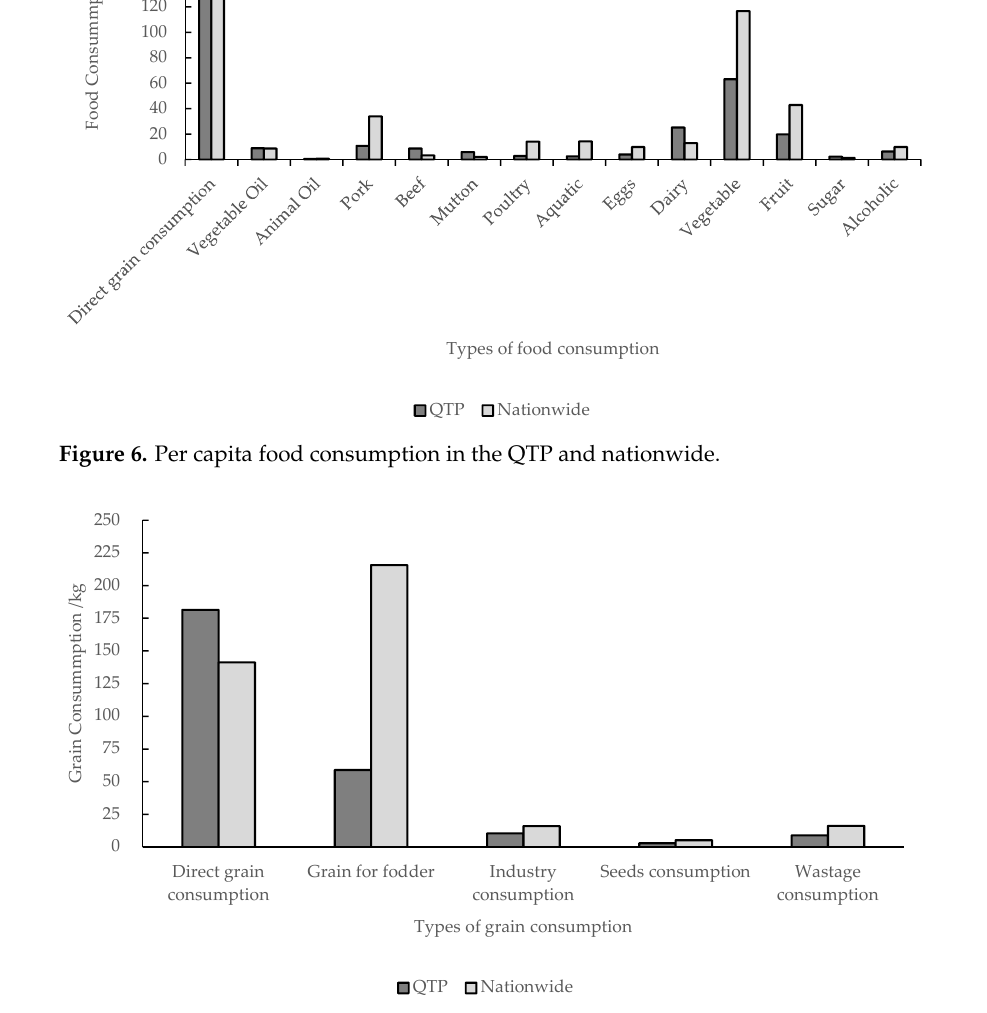
Figure 7. Per capita grain consumption of the well-off nutritional level in the QTP and nationwide.